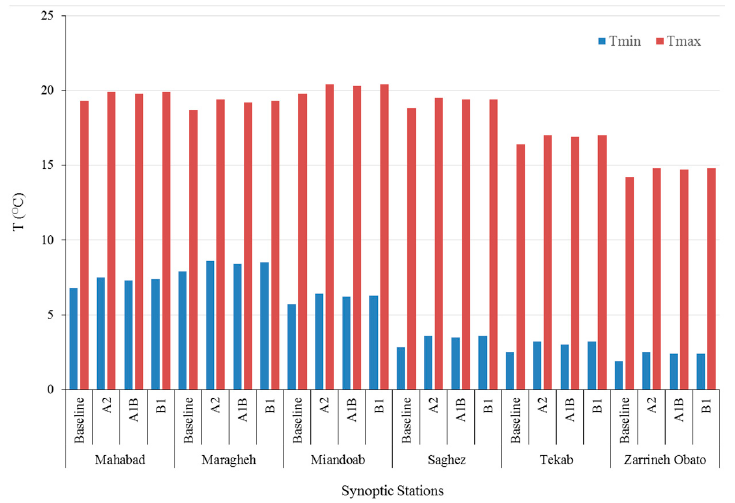
Figure 5. Comparison of mean precipitation of the studied stations in the future period (2015–2040) under different emission scenarios as compared to the baseline period (1986–2010).